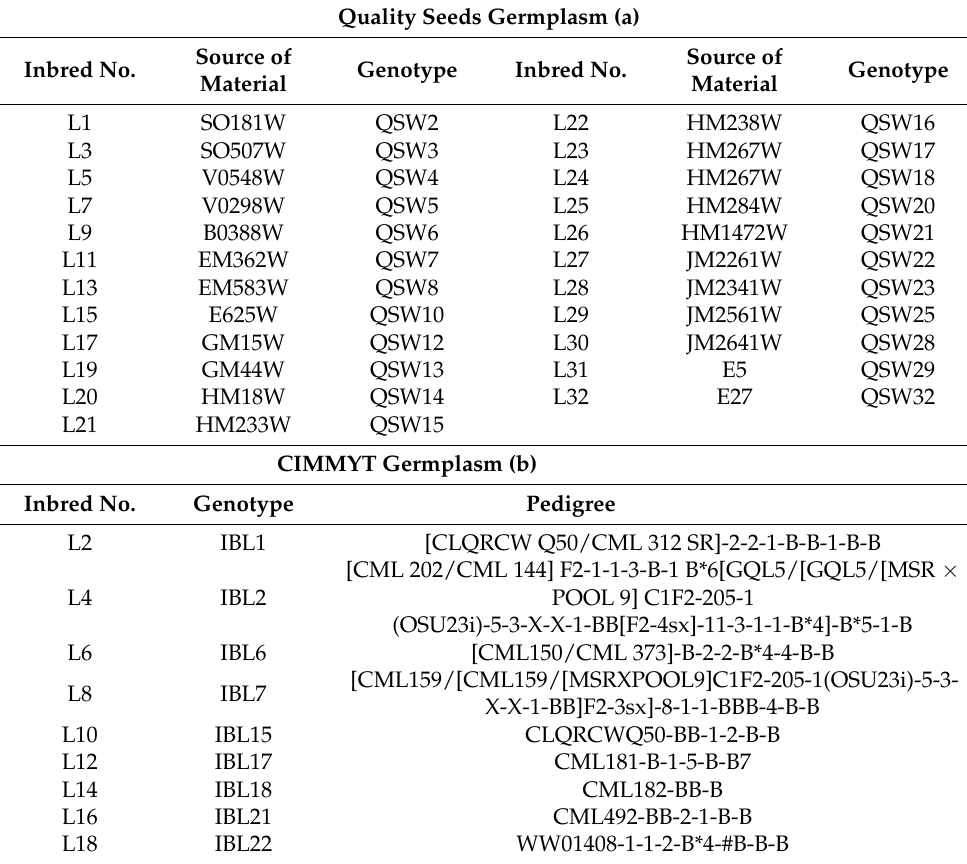
Table 1. List of parental inbred lines that were screened for low nitrogen stress tolerance. Quality Seeds Germplasm (a) Inbred No. Inbred